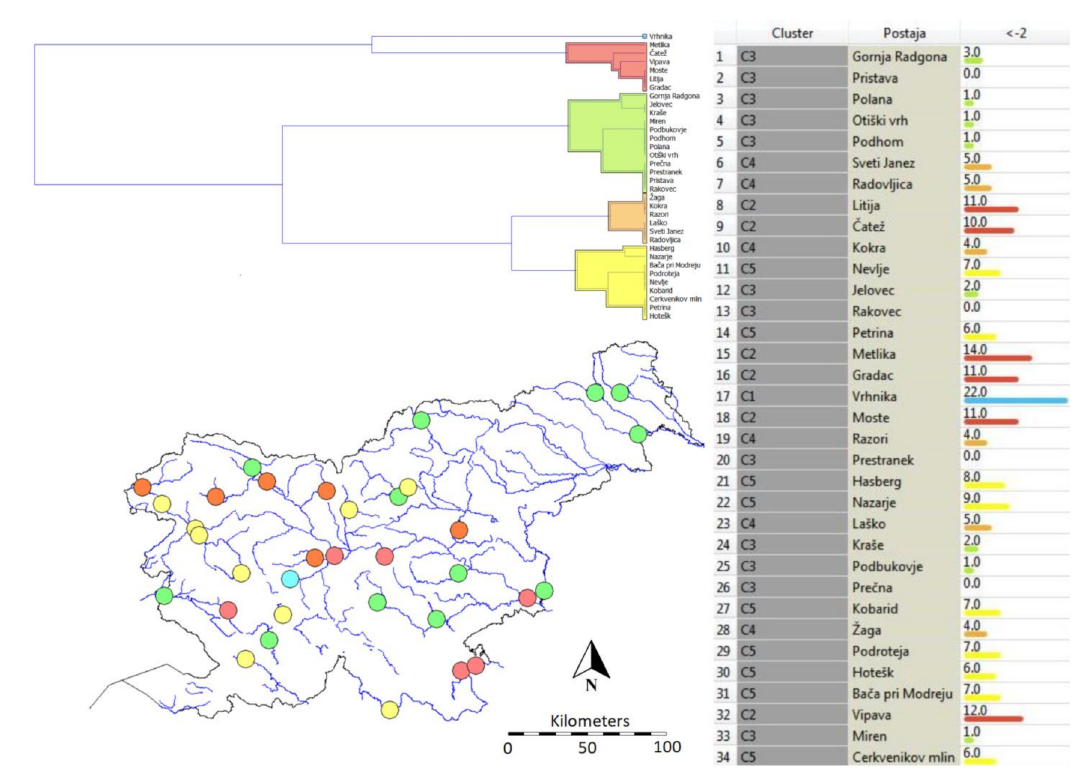
Figure 6. Hierarchical clustering of the number of extreme droughts using the one month time scale (SSI-1 < − 2) and spatial presentation of the results on the map of Slovenia. Groups are indicated by colours: C1 (blue), C2 (red), C3 (green), C4 (orange), and C5 (yellow).